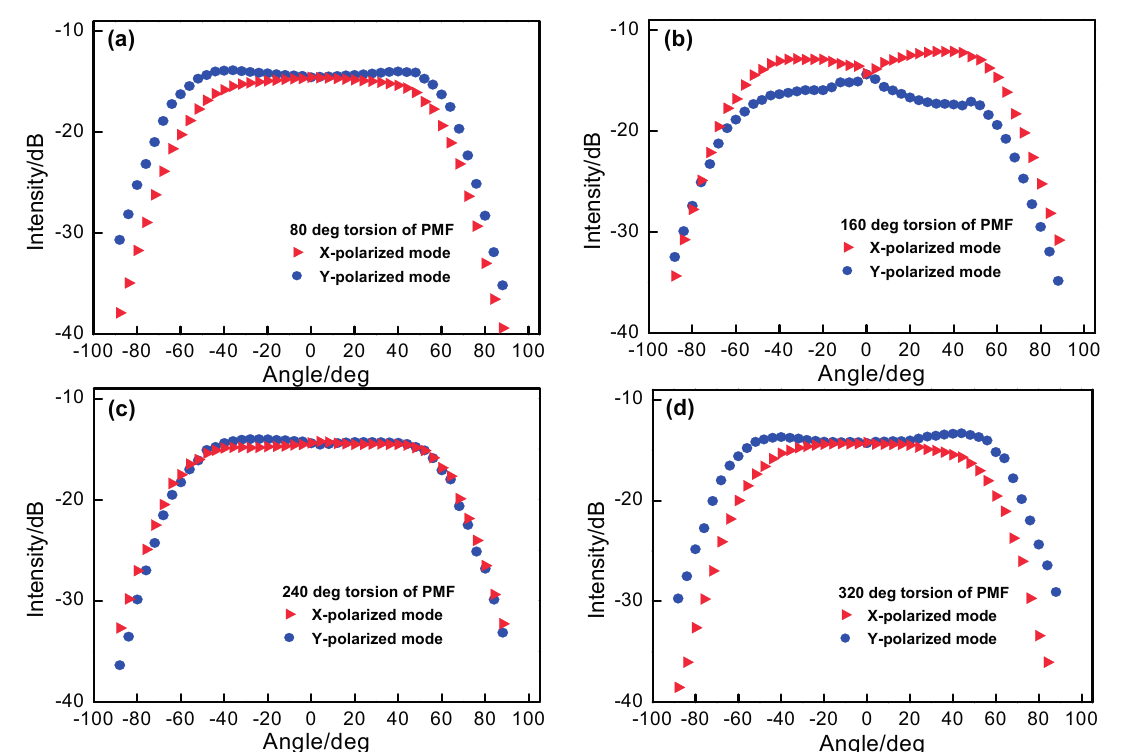
Figure 5. Device’s responses to bending angle at the different rotation orientations of PMF, ( a ) 80°; ( b ) 160°; ( c ) 240° and ( d )